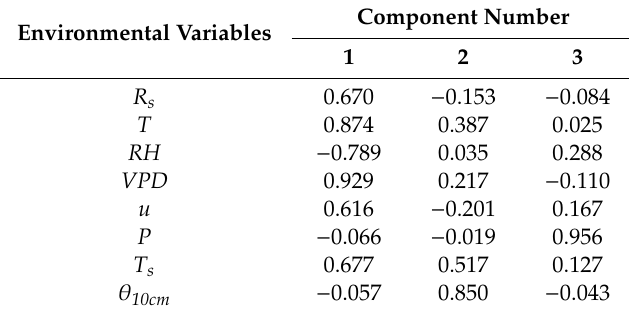
Table 3. Factor loadings on the first three PCA